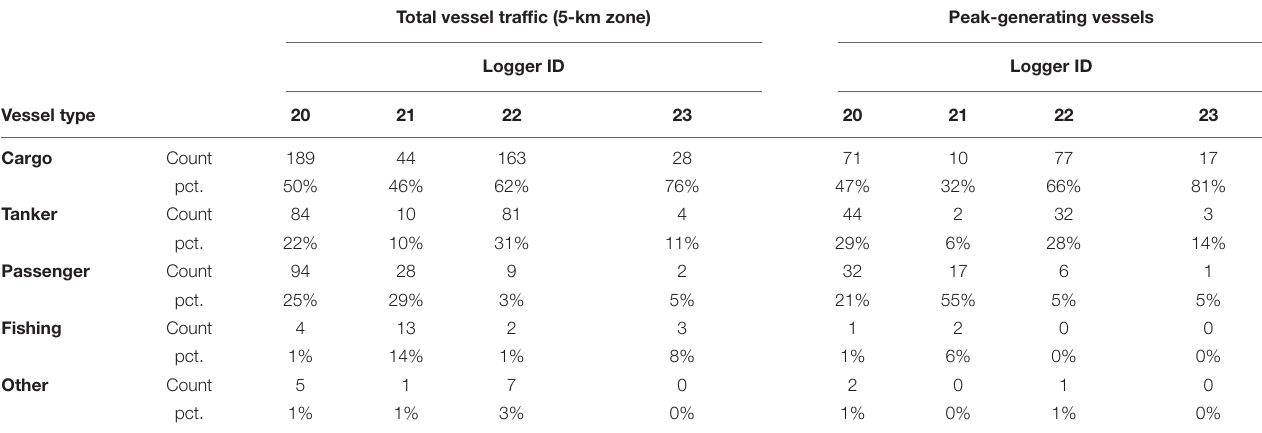
TABLE 3 | The count and percentage (pct.) of different vessel types near the